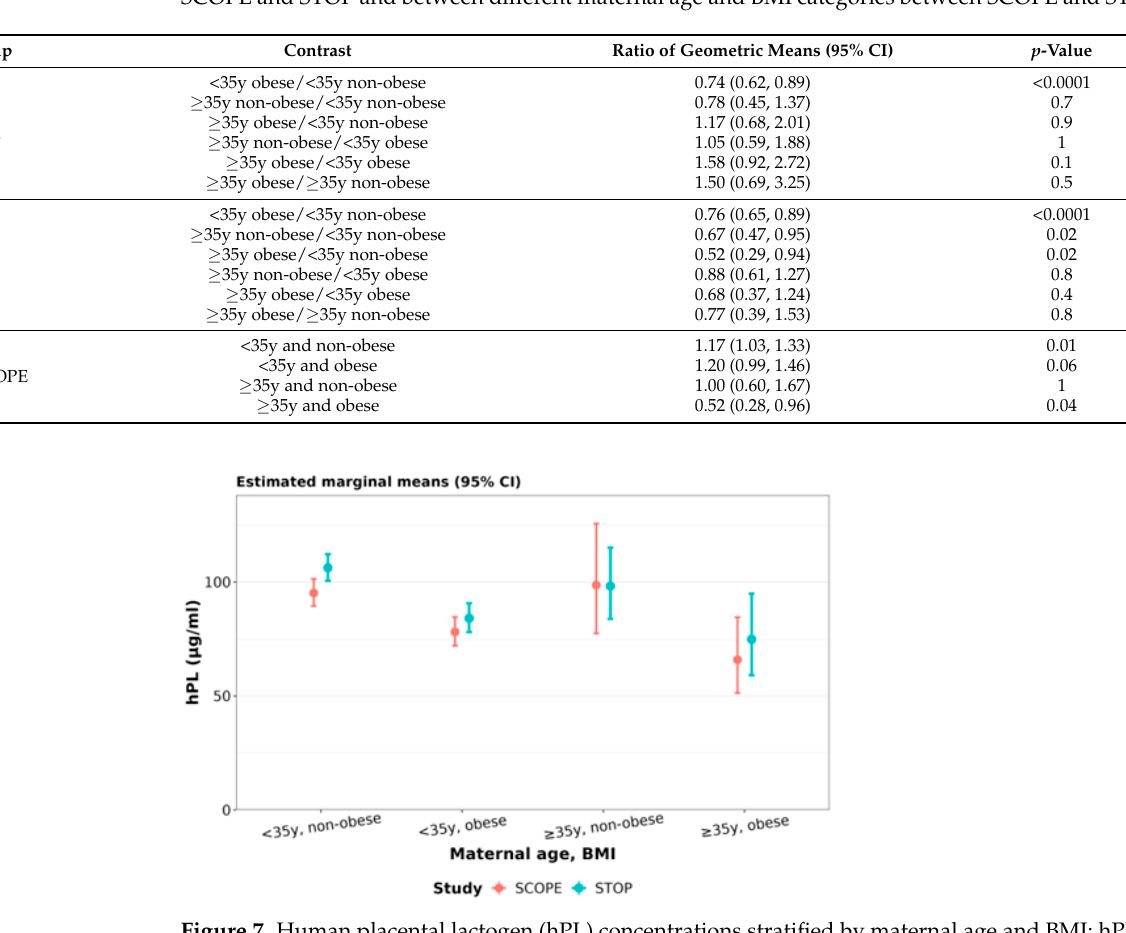
Figure 6. Prolactin concentrations stratified by maternal age and BMI: PRL in early gestation SCOPE (N = 465) and STOP (N = 684) women was stratified by maternal age and BMI status. Women were stratified as younger than 35y or 35y and older, and non-obese (healthy BMI) and obese. Table 7. Post hoc comparisons for Prolactin (PRL) in different maternal age and BMI categories within SCOPE and STOP and between different maternal age and BMI categories between SCOPE and STOP.